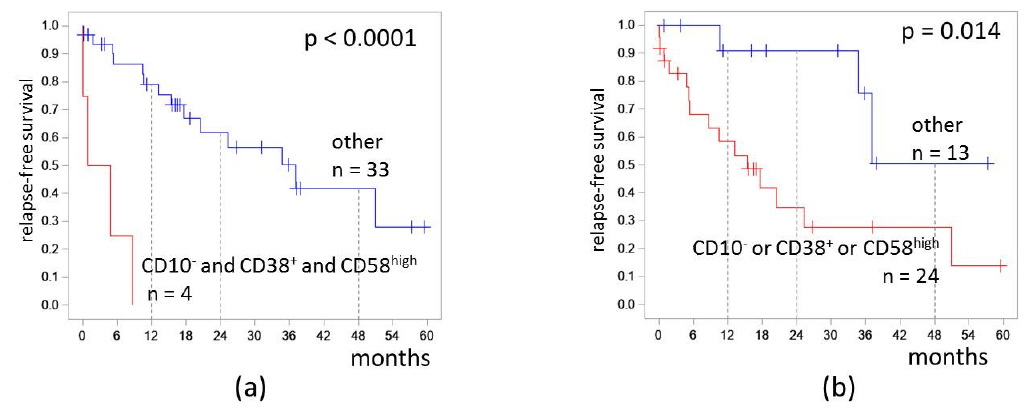
Figure 6. Relapse-free survival of patients depending on expressions of CD10, CD38, and CD58 on measurable residual blast cells detected at the end of induction: ( a ) combination of CD10 − and CD38 + and CD58 high ; ( b ) CD10 − , CD38 + , or CD58 high immunophenotype. The initial date was the end of induction.